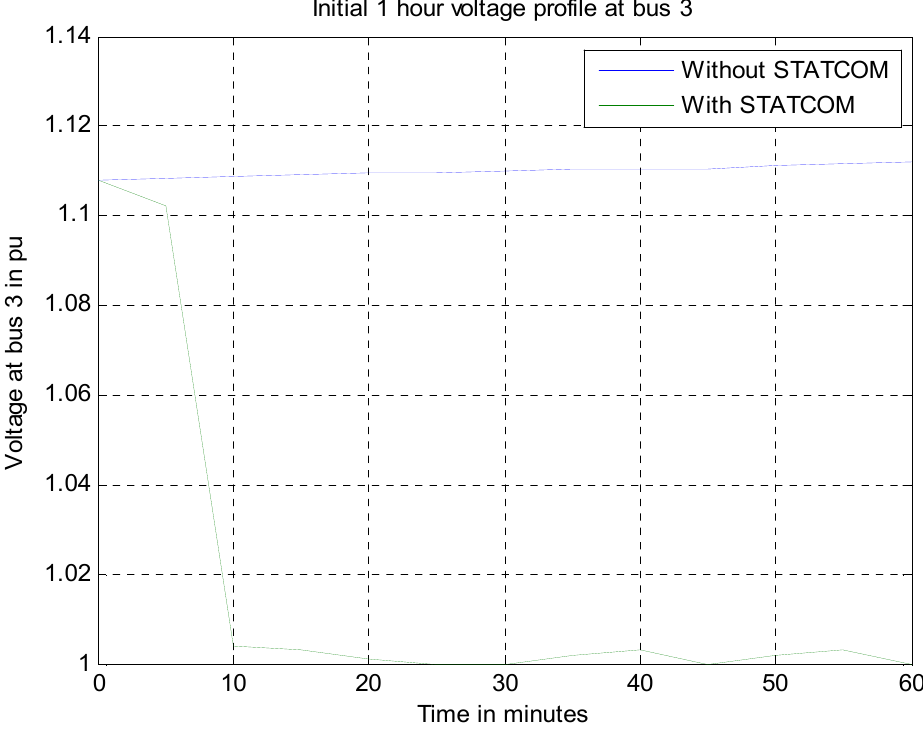
Figure 7. Node 3 voltage with/without STATCOM (one hour profile).